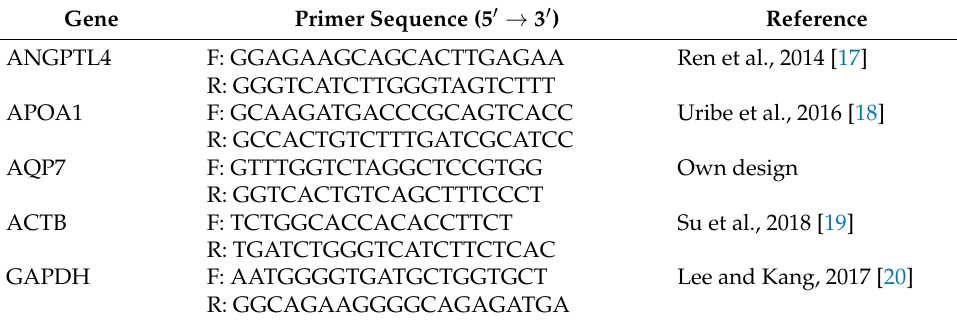
Table 1. Primers used for qRT-PCR validation.